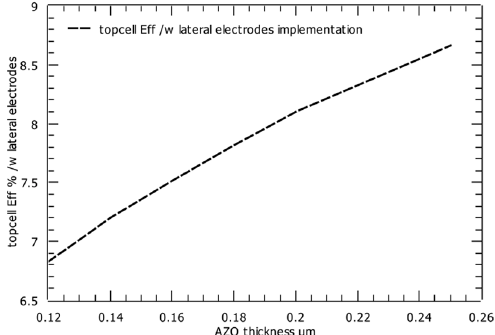
Figure 2. AZO (Al:ZnO) thickness vs. top cell efficiency.